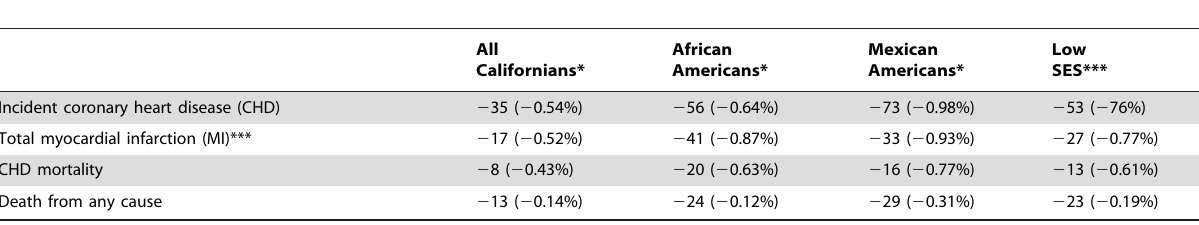
Table 4. Projected difference in event rates per million person-years after a 10% SSB consumption reduction, across subgroups of California (Percent change).